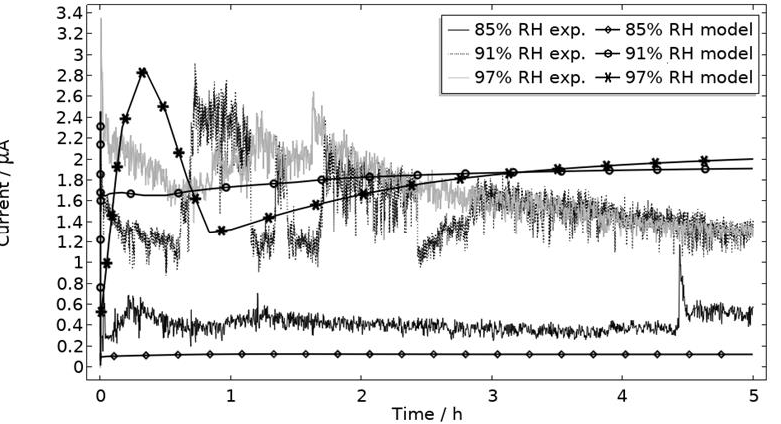
Figure 9. Experimental and modeled galvanic current during 5 h exposure of the calibration cell with 86 μ g NaCl/cm 2 load at 21 °C at 85%, 91%, and 97% RH.